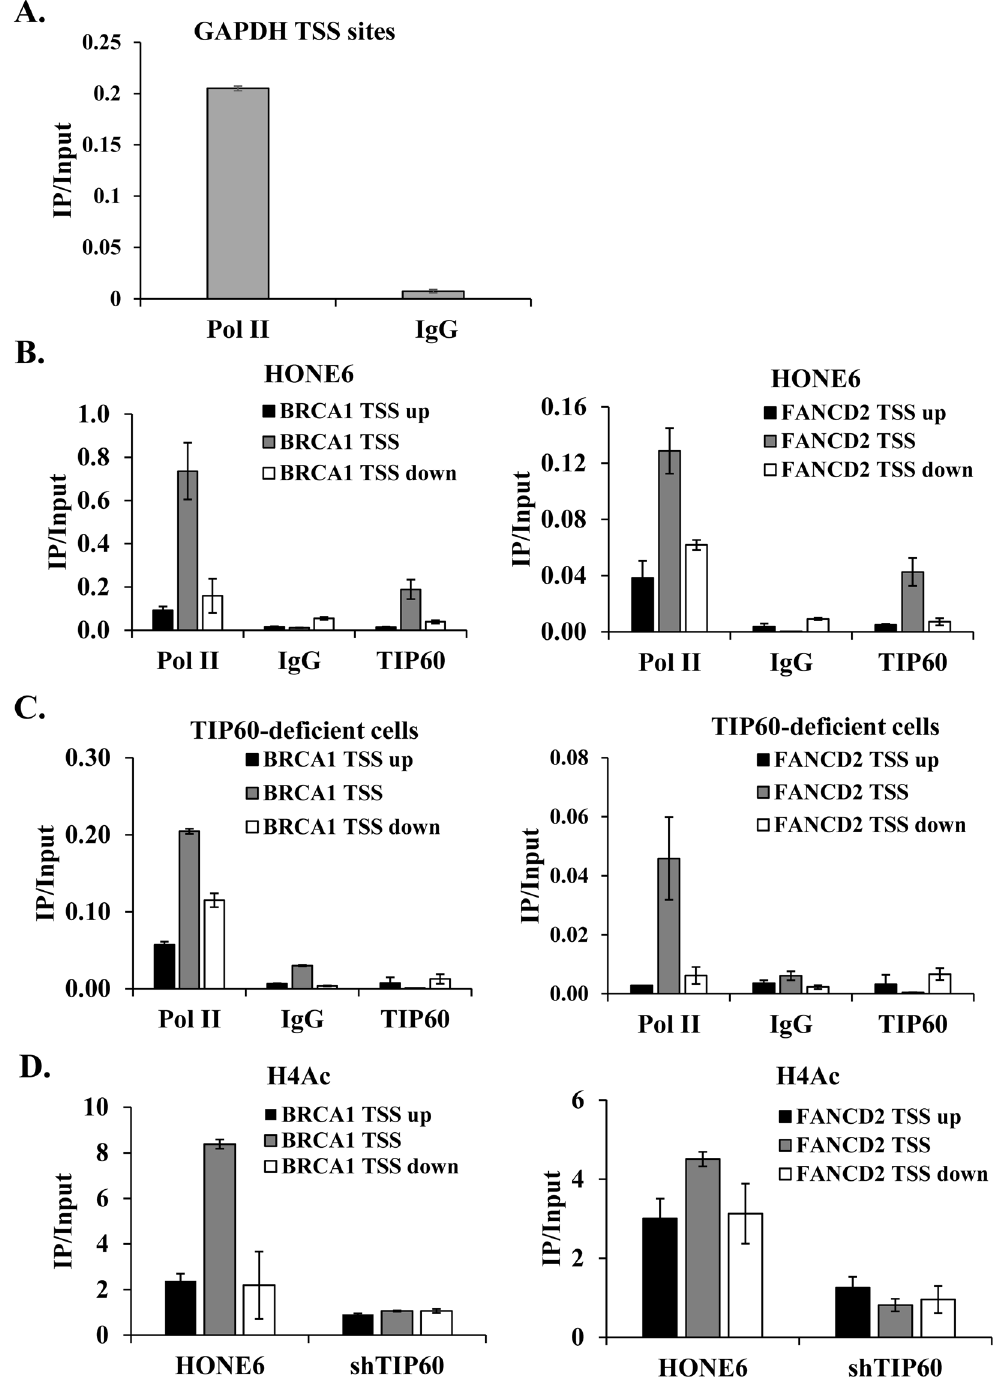
Figure 8. TIP60 binds to the promoter of BRCA1 and FANCD2. The ChIP experiments were performed in HONE6 and TIP60-deficient (shTIP60) cells with anti-RNA Pol II (Pol II, positive control), mouse IgG (negative control), anti-TIP60 and anti-H4ac antibodies. The immunoprecipitated DNA fragments were quantified with qPCR with specific primers located at the transcription start site (TSS) of GAPDH, and at the TSS sites and at the 2 kb sites upstream (TSS up) or downstream (TSS down) from the TSS sites of BRCA1 and FANCD2. The protein enrichment at the TSS, TSS up, and TSS down sites were determined by the amount of pulldown DNA fragments relative to the amount of the input DNA. ( A ) RNA Pol II was enriched at the TSS sites of GAPDH. ( B ) TIP60 was enriched at the TSS sites of BRCA1 and FANCD2. ( C ) the enrichment of TIP60 was dramatically reduced in the TIP60-depleted cells. ( D ) H4ac was enriched at the TSS sites of BRCA1 and FANCD2. Depletion of TIP60 dramatically reduces the enrichment of H4ac at these sites. Each value represents the mean ± standard deviation from at least three